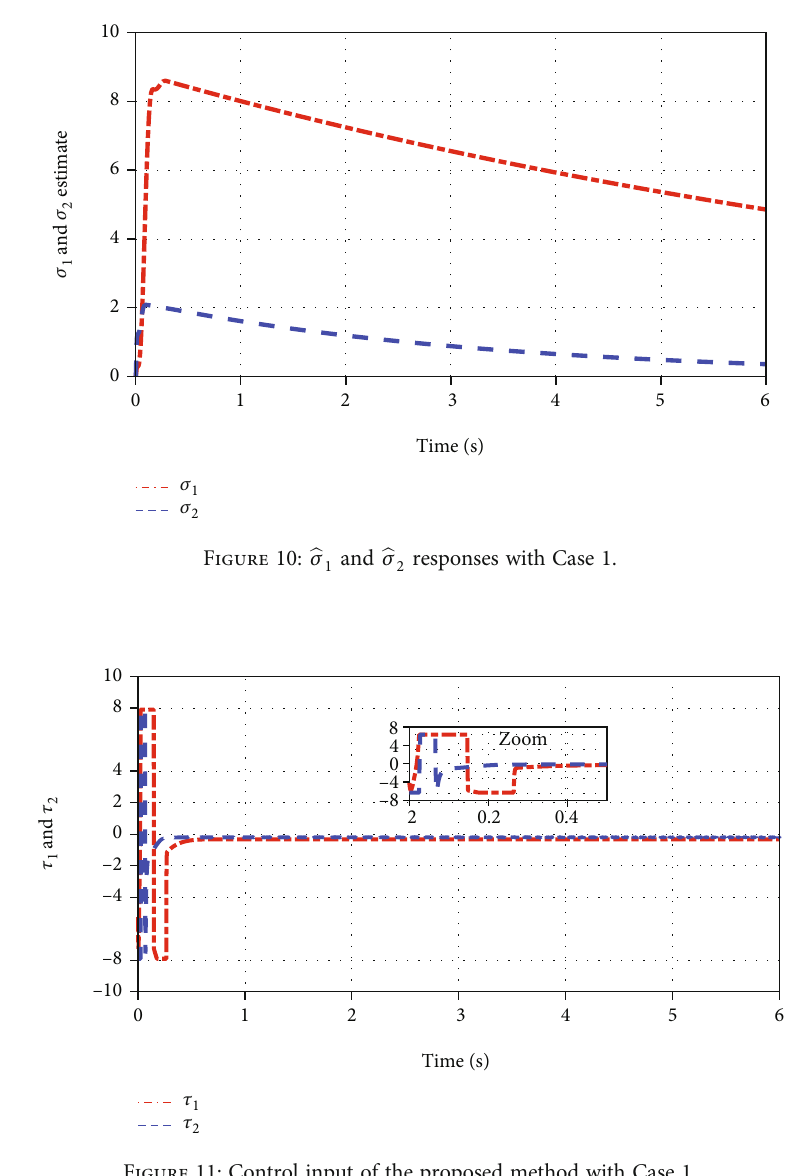
Figure 11: Control input of the proposed method with Case